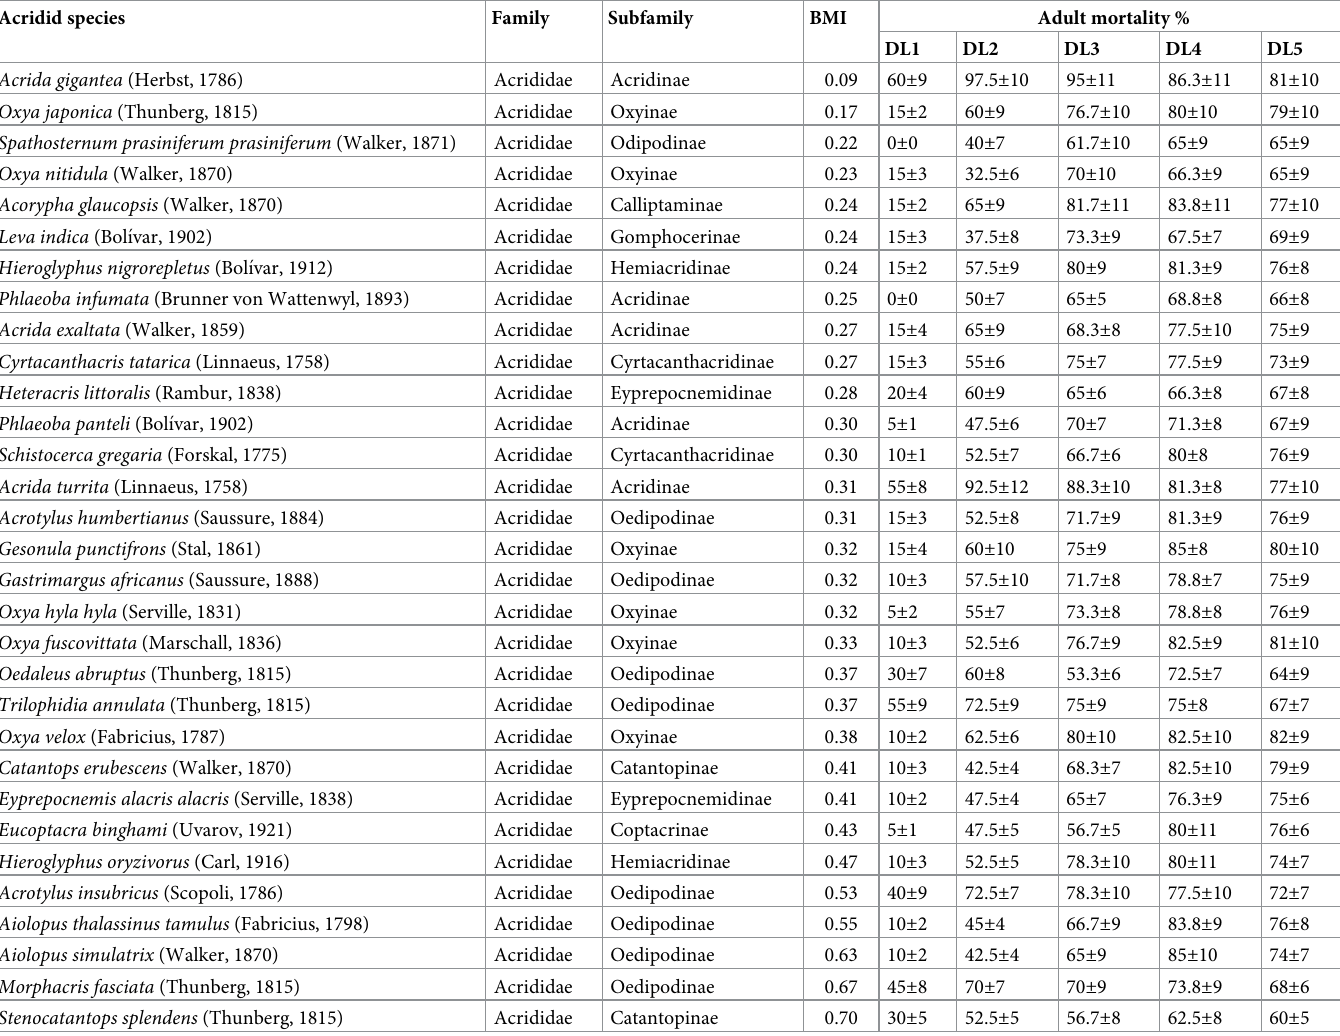
Table 1. Adult acridid mortality (species, n = 31; family, n = 1; subfamily, n = 12) at different density levels (DL1 to